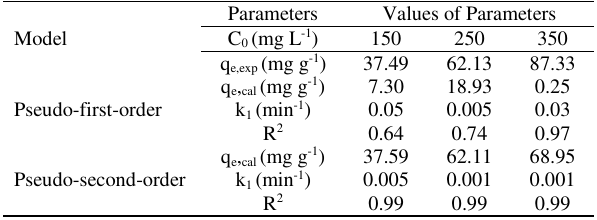
Table 4. Kinetic parameters and correlation coefficients for fitting of pseudo first and second order model.